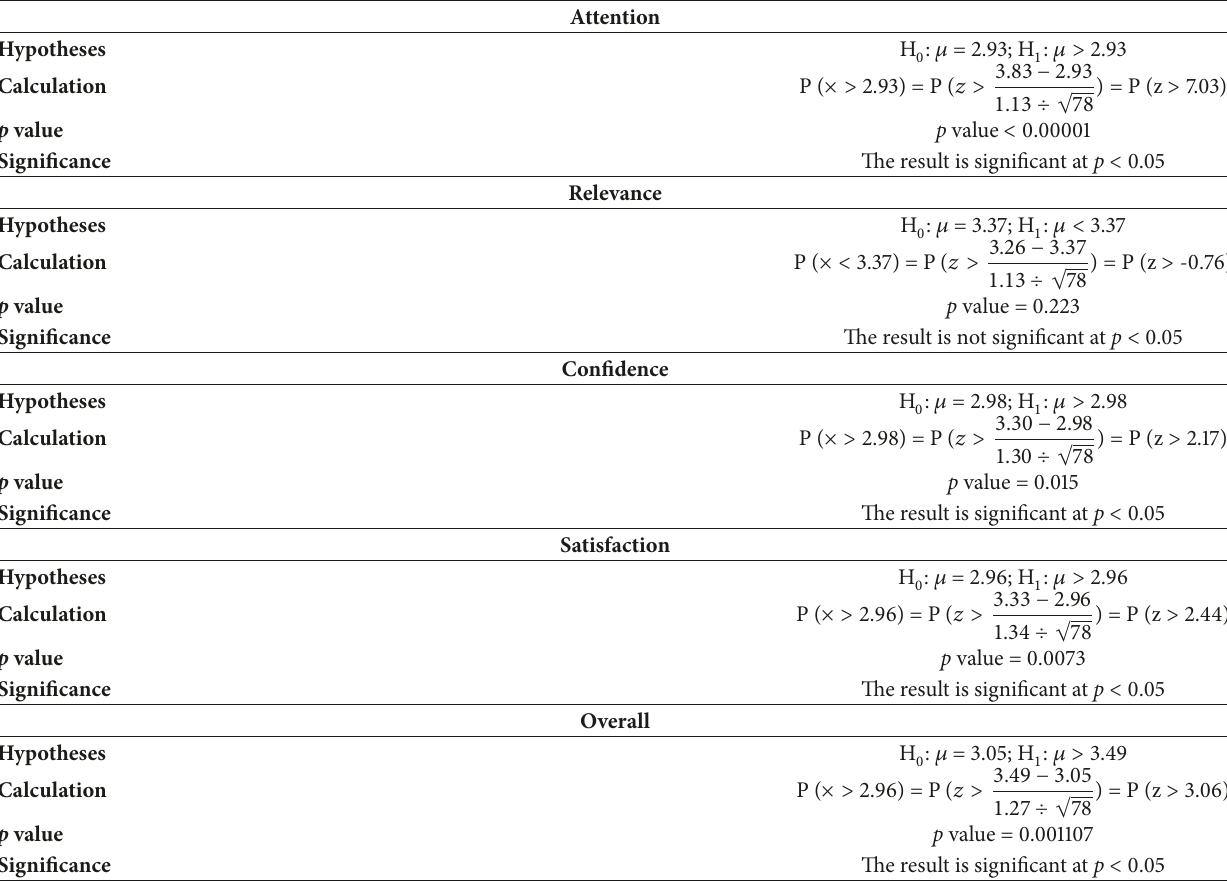
Table 2: Significance of differences in mean values.